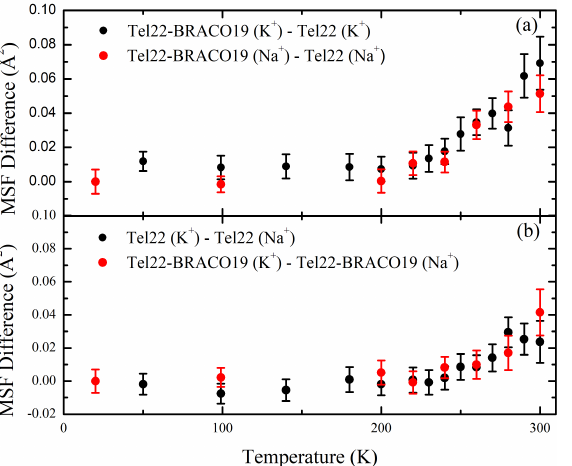
Figure 4. Comparison of MSF of different samples as a function of temperature, considering the effects induced by complexation ( a ) and by ionic environment ( b